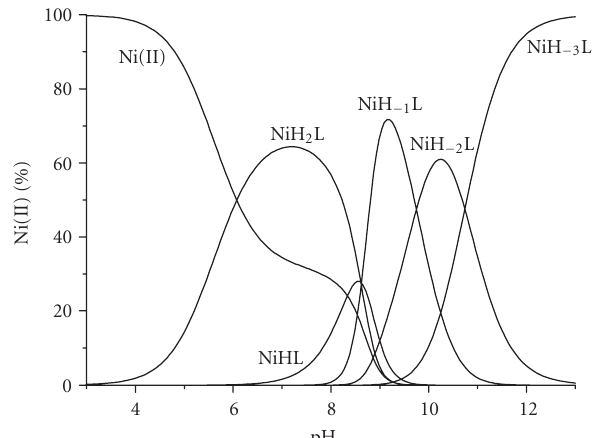
Figure 3: Species distribution diagram of Ni(II) complexes with - LAHYNK- (1 : 2), C peptide =